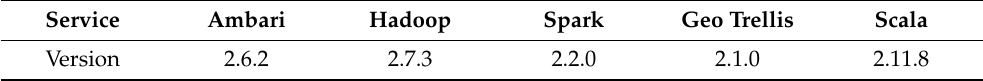
Table 3. The version information of the basic services in the distributed cluster. Service